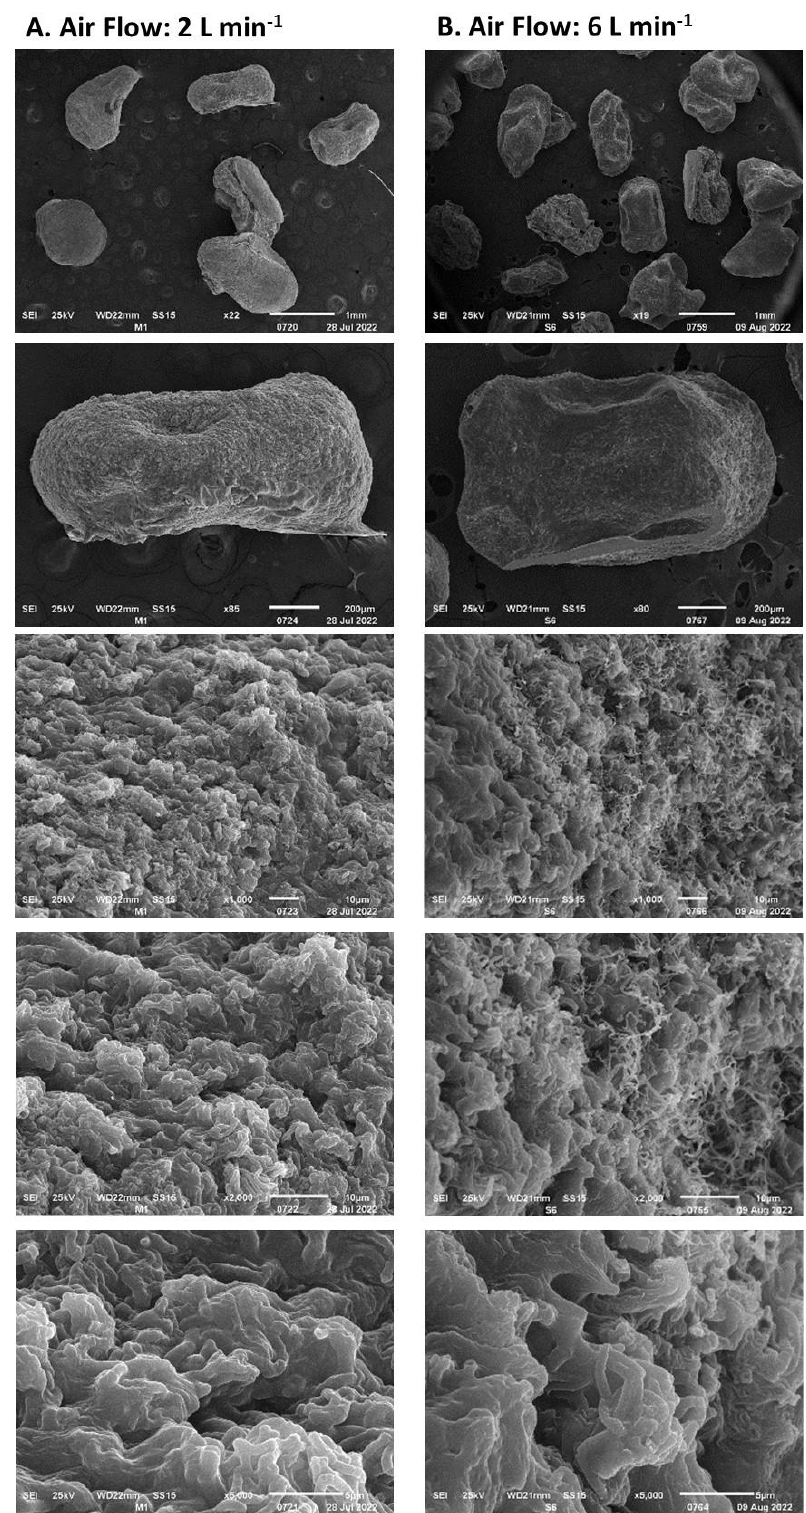
Figure 8. The Streptomyces CDBB1232 mycelium encapsulated and dehydrated with airflow: ( A ). 2 L min −1 , ( B ) . 6 L min −1 , at room temperature.